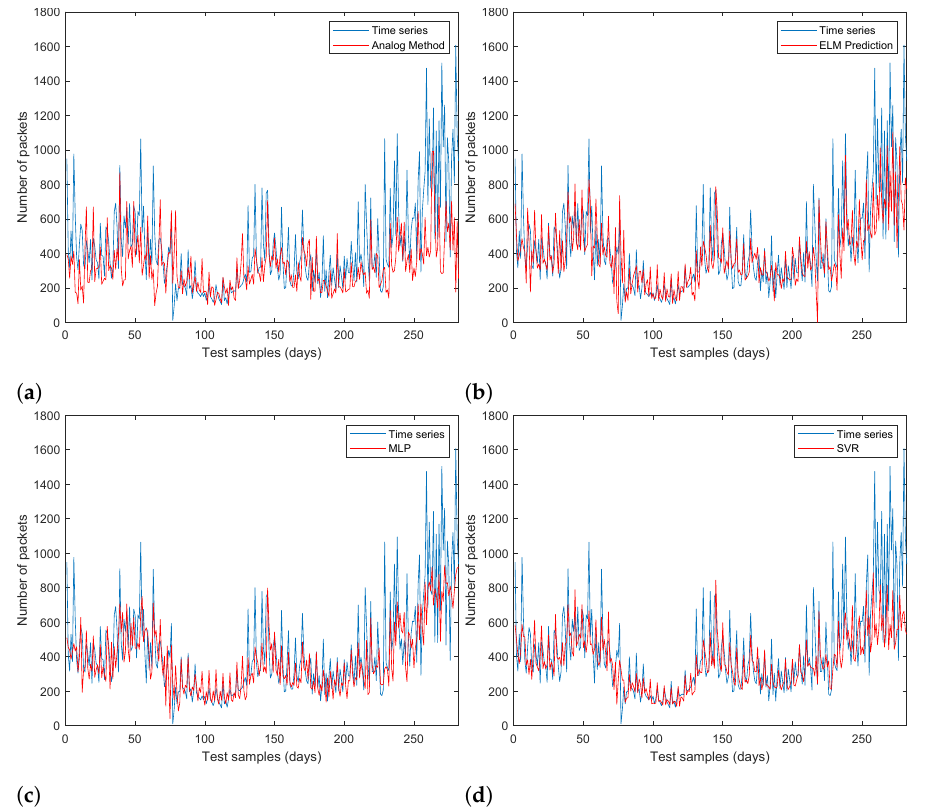
Figure 7. Performance of the different regressors considered in the prediction problem over packets delivery dataset at Azuqueca. ( a ) ANA; ( b ) ELM; ( c ) MLP; ( d ) SVR.